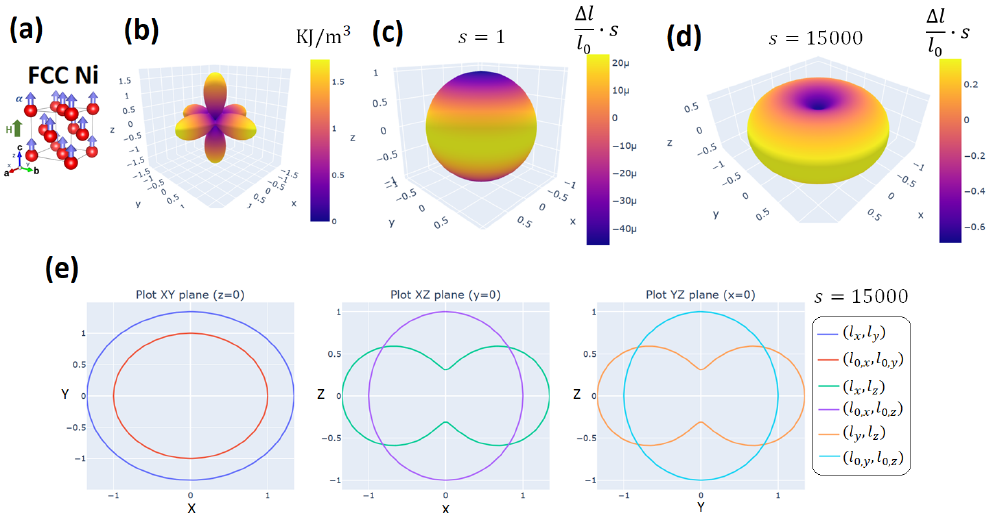
Figure 7. Mapping the Joule effect to a sphere for single-crystal FCC Ni at room-temperature under an external magnetic field parallel to the z-axis. ( a ) Unit cell of FCC Ni. ( b ) 3D visualization of the magnetocrystalline anisotropy energy. 3D visualization of the simulated length l sim via Equation (14) with scale factor ( c ) s = 1 and ( d ) s = 15,000. The color of the surface corresponds to the relative length change multiplied by the scale factor. ( e ) Cross-section of the simulated length l sim with scale factor s = 15,000 in the planes XY (z = 0), XZ (y = 0), and YZ (x = 0).